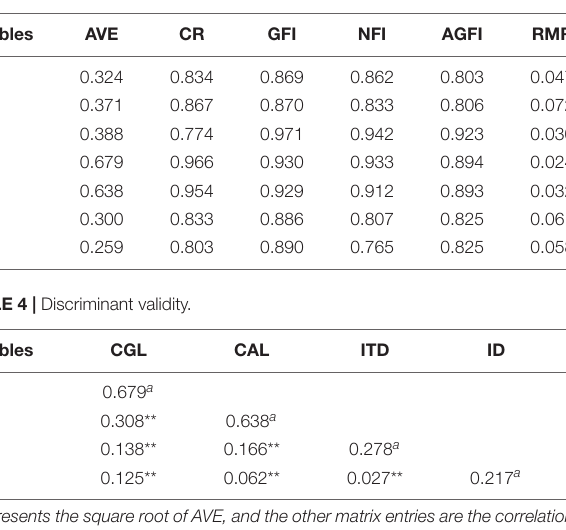
TABLE 3 | Convergent validity.